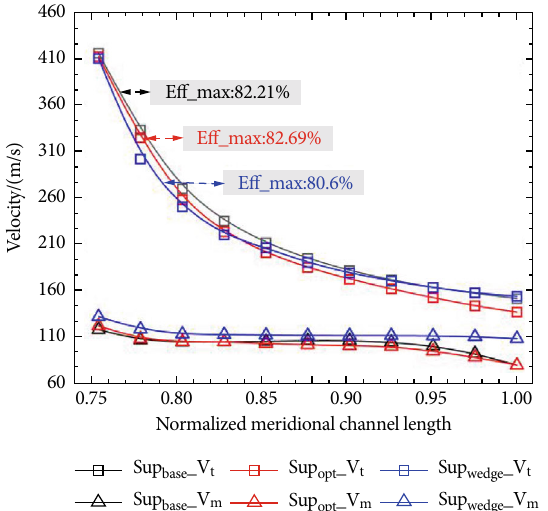
Figure 18: Velocity distributions for the di ff user of the subsonic